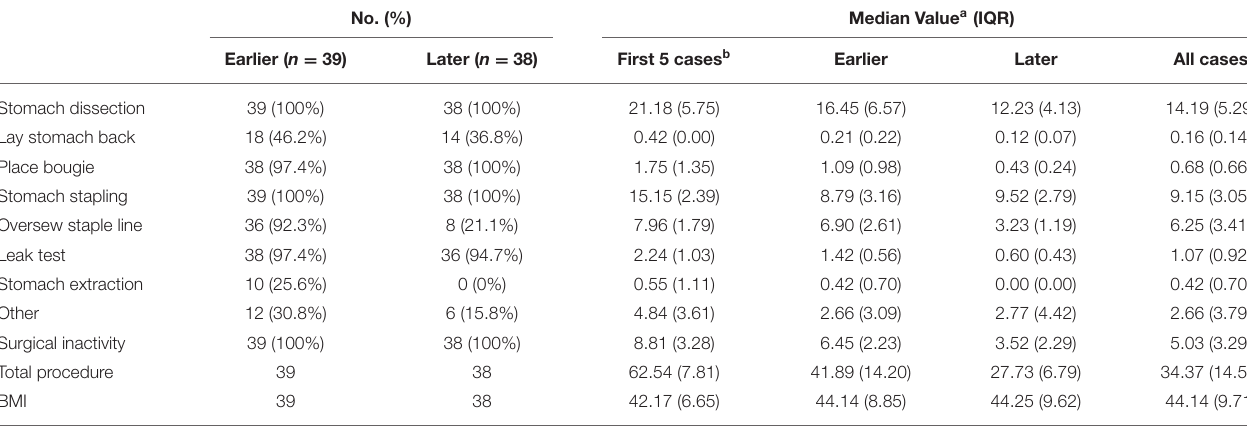
TABLE 1 | Statistics of surgical tasks, procedure duration and BMI.